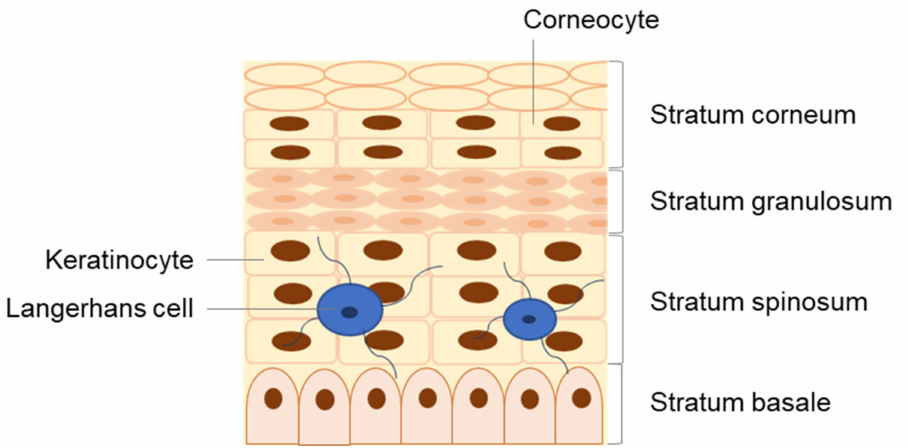
Figure 2. Detailed structure of the epidermis, composed of four distinct strata: the stratum basale , stratum spinosum , stratum granulosum , and stratum corneum